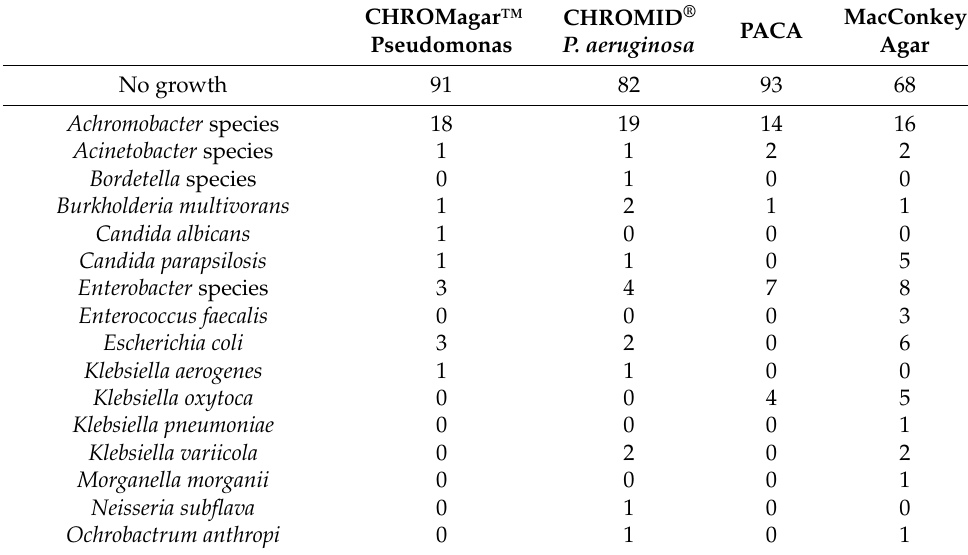
Table 2. Species other than P. aeruginosa recovered on the four test media during the 72 h